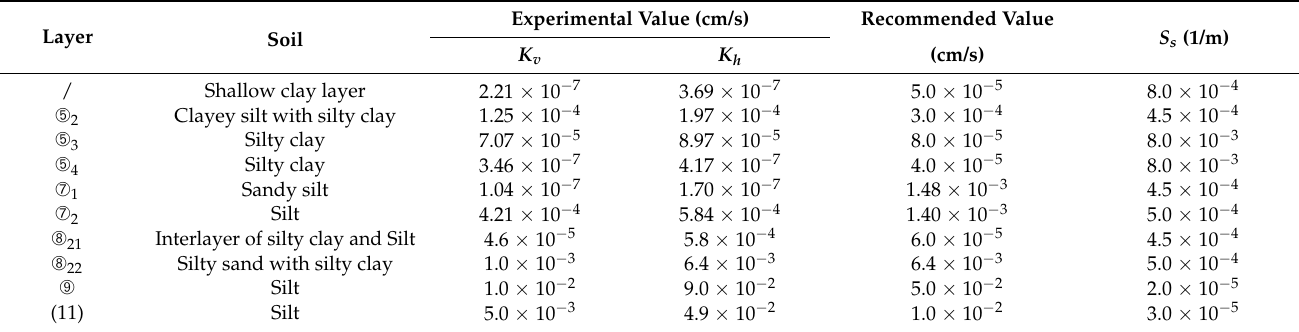
Table 2. Hydraulic conductivity of the soil layers.